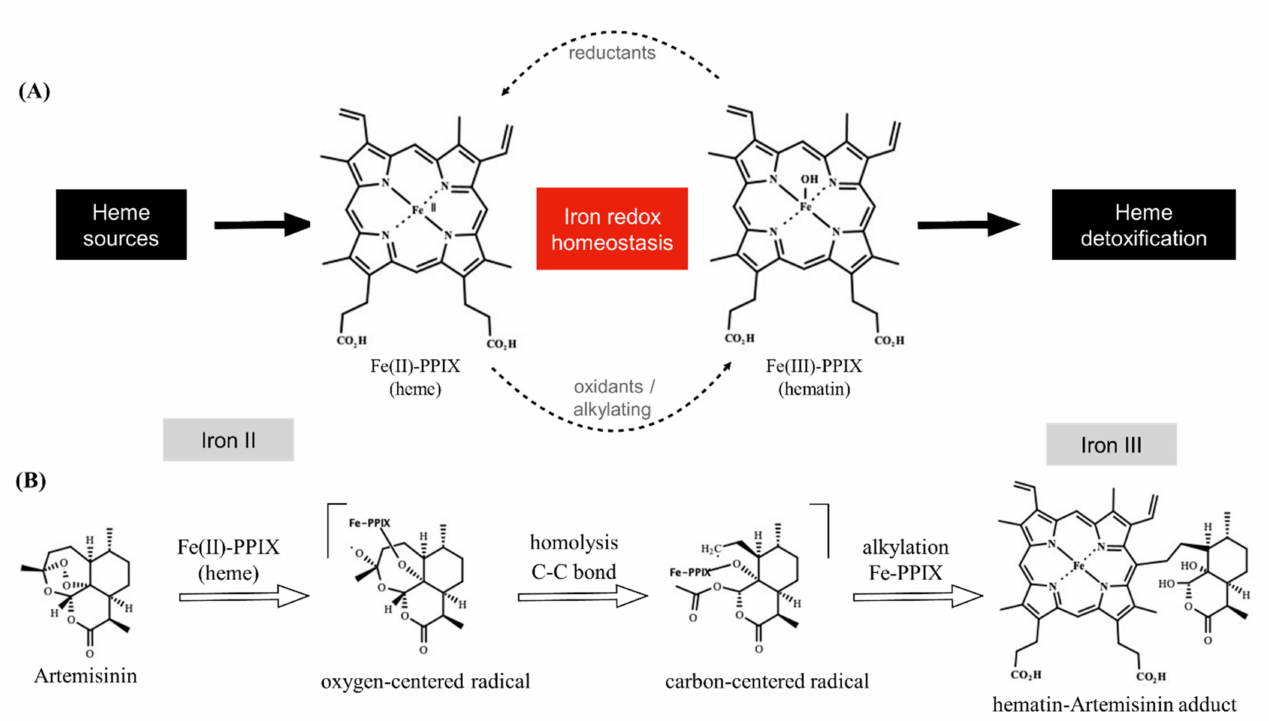
Figure 1. Overview of iron redox chemistry and the drug blockage. Panel ( A ) shows that the oxidative state of iron is regulated in the parasite. Heme is oxidized by oxygen into hematin, which is then biomineralized within the heme detoxification process. A shift in the homeostasis towards heme can be induced by endogenous reductants (a formal possibility being glutathione). A shift in the homeostasis towards hematin can be induced by alkylating agents, such as artemisinin. Panel ( B ) shows that artemisinin undergoes reductive activation by heme, producing a radical species. This can alkylate a variety of molecules (not depicted), including Fe-PPIX. Heme alkylation results in the hematin–artemisinin adduct (for clarity, only one isomer adduct is depicted). Note that heme alkylation is accompanied by the exchange of the iron oxidative state from ferrous to ferric Fe-PPIX. Unless specified, iron is in a ferric state. Fe-PPIX = iron protoporphyrin